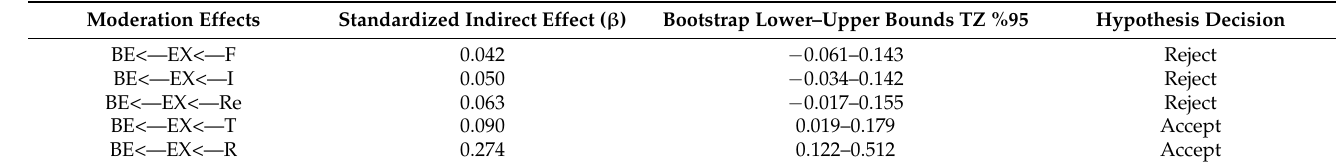
Table 8. Moderation effect of